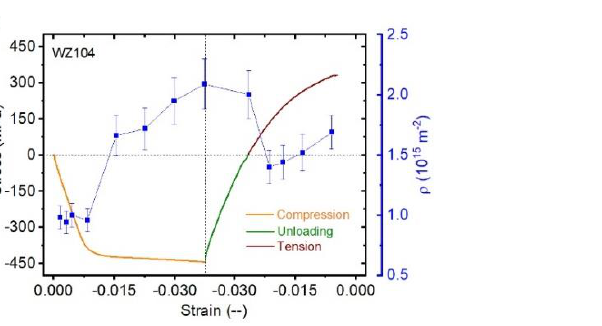
Figure 7. The evolution of the dislocation density in α -Mg phase as a function of applied stress for the ( a ) WZ42, ( b ) WZ72, and ( c ) WZ104 alloys.